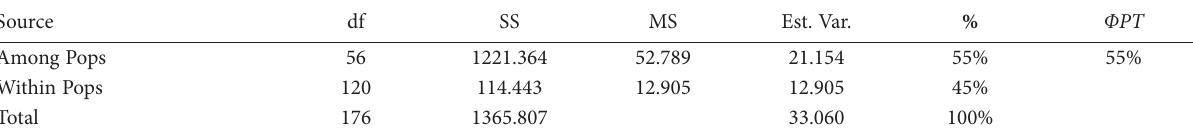
Table 4. Analysis of molecular variance (AMOVA) of the studied Salicornia persica. Source df SS MS Est. Var. % ΦPT Among Pops 56 Within Pops 120